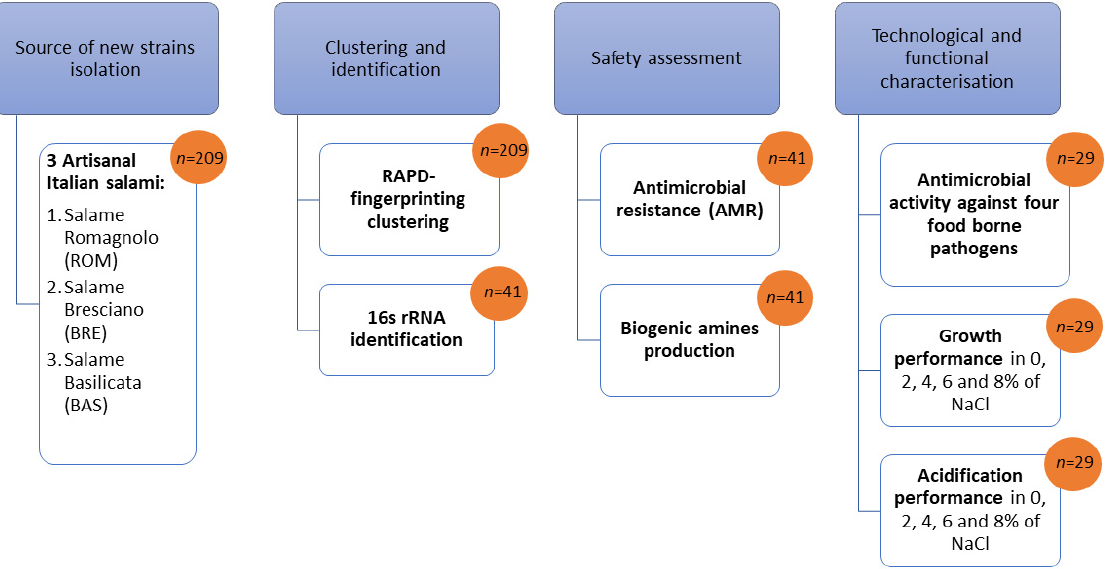
Figure 1. Summary of the screening procedure for isolation and characterization of new potential bioprotective starter lactic acid bacteria ( n = number of isolates).